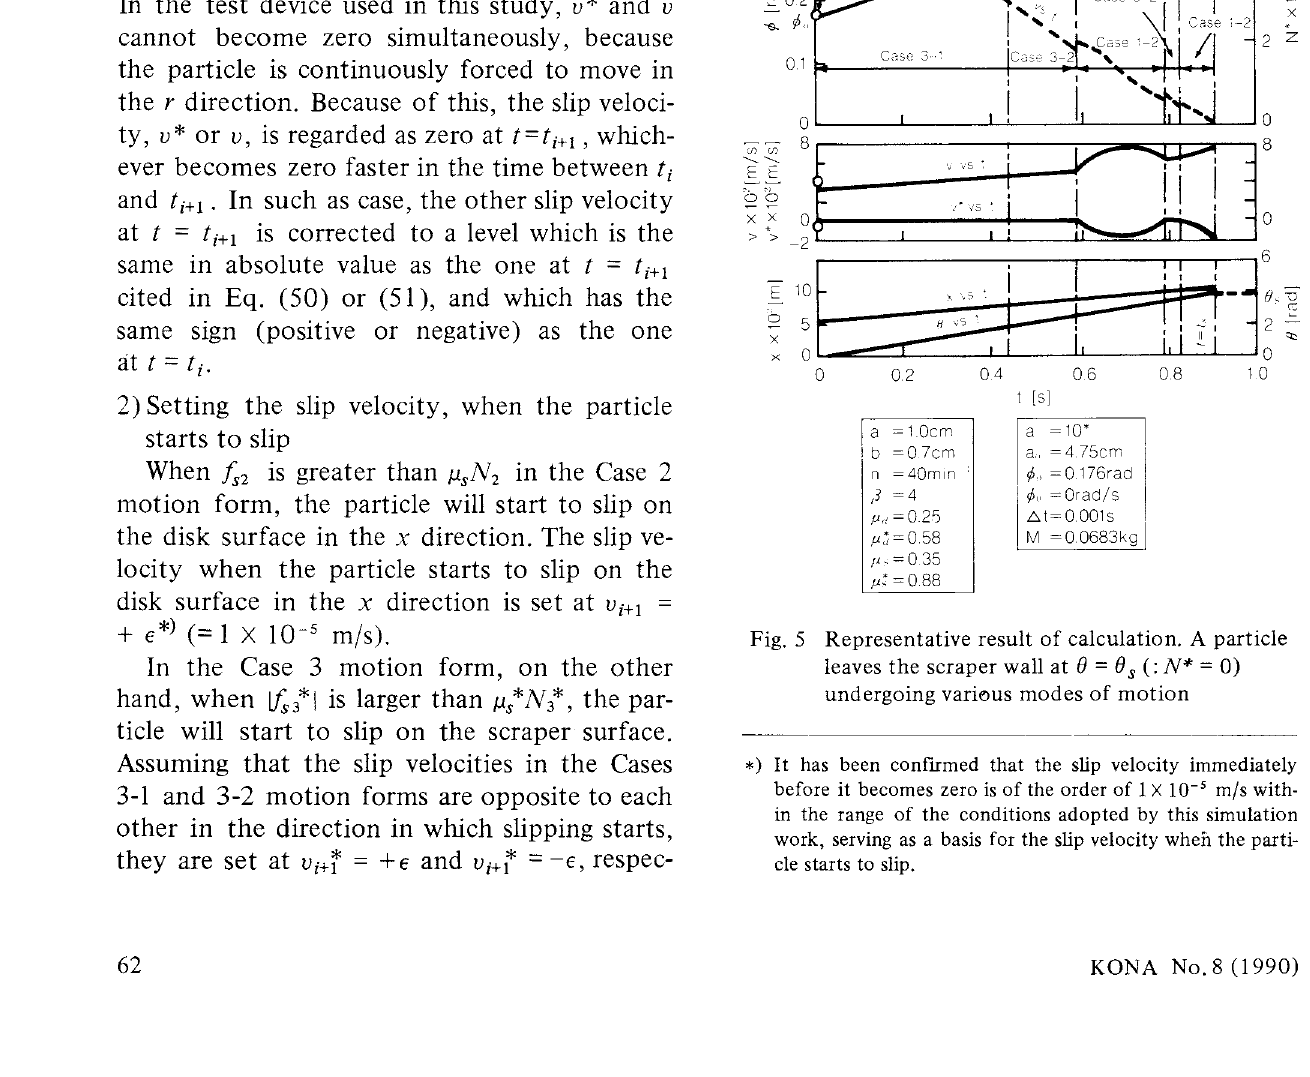
Fig. 5 Representative result of calculation. A particle leaves the scraper wall at 8 = 8 s (: N* = O) undergoing variems modes of